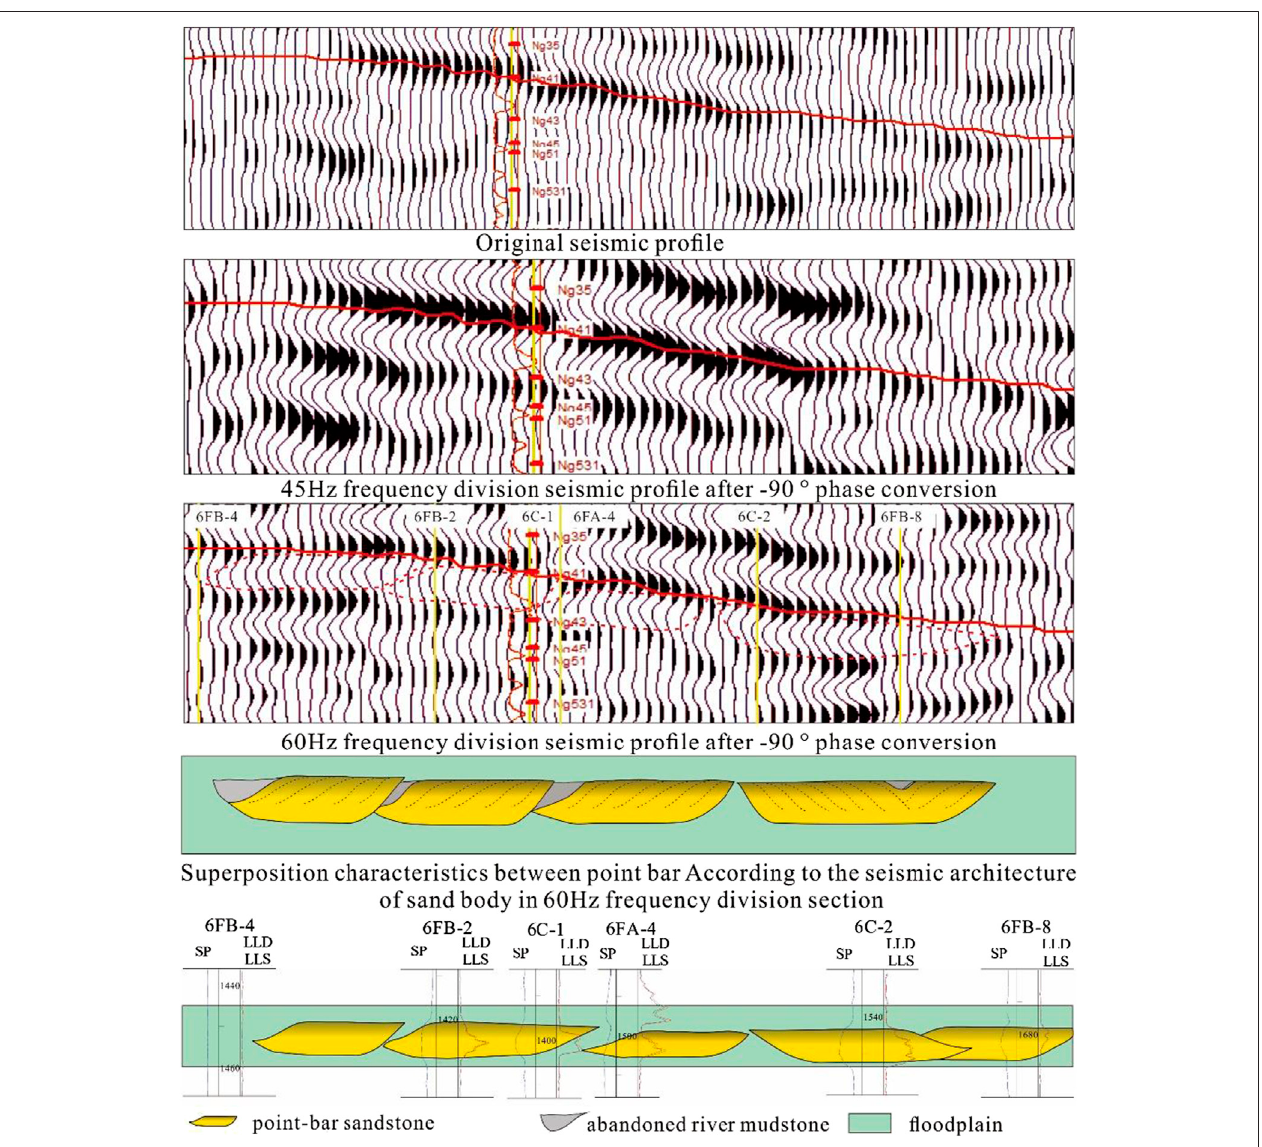
FIGURE 9 | Architectural characteristics of typical point bar in Ng42 sub-layer, seismic and logging interpretation pro fi le, and results. Interpretation of point bars in meander-river belt of Ng45 sub-layer.